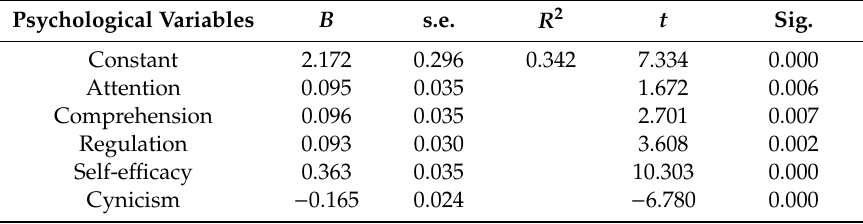
Table 4. Emotional intelligence and academic burnout on goal orientation (task). Psychological Variables